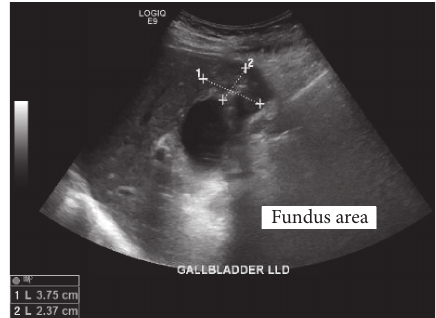
Figure 2: Right upper quadrant ultrasound showing 3.8 × 2.4 × 3.5 heterogeneous mass with small calcification emanating from the gallbladder fundus.